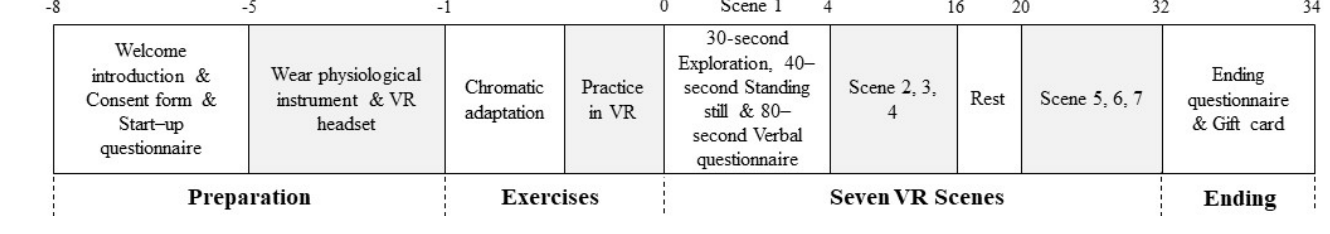
Figure 5. VR experiment protocol .